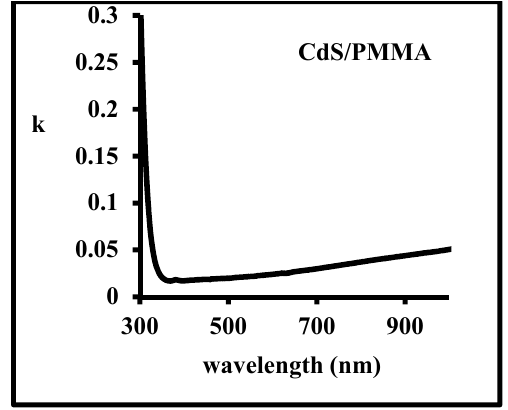
5: Extinction coefficient as a function of wavelength for CdS/PMMA thin film. b) Refractive